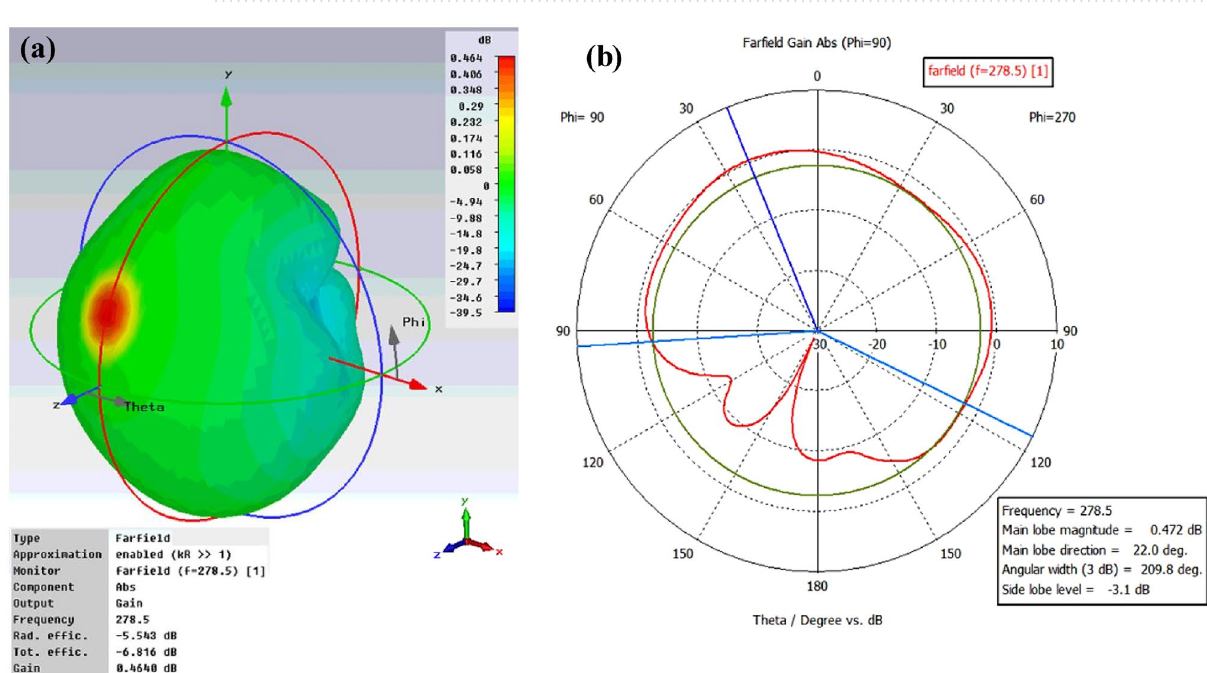
Figure 8. ( a ) 3D and ( b ) polar plot of farfield directivity of the proposed unit-cell broadband antenna at 278.5 THz.